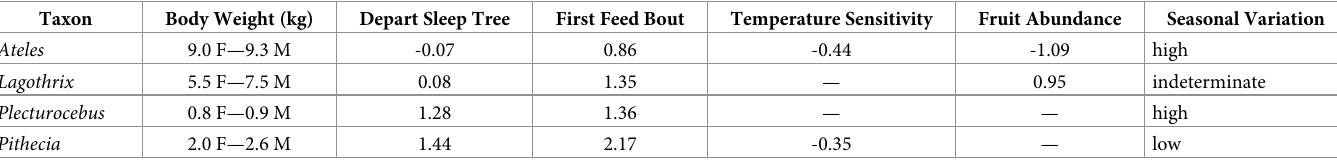
Table 8. Relationships of first movements and feeding times to biotic and abiotic factors. Taxon Body Weight (kg) Depart Sleep Tree First Feed Bout Temperature Sensitivity Fruit Abundance Seasonal Variation